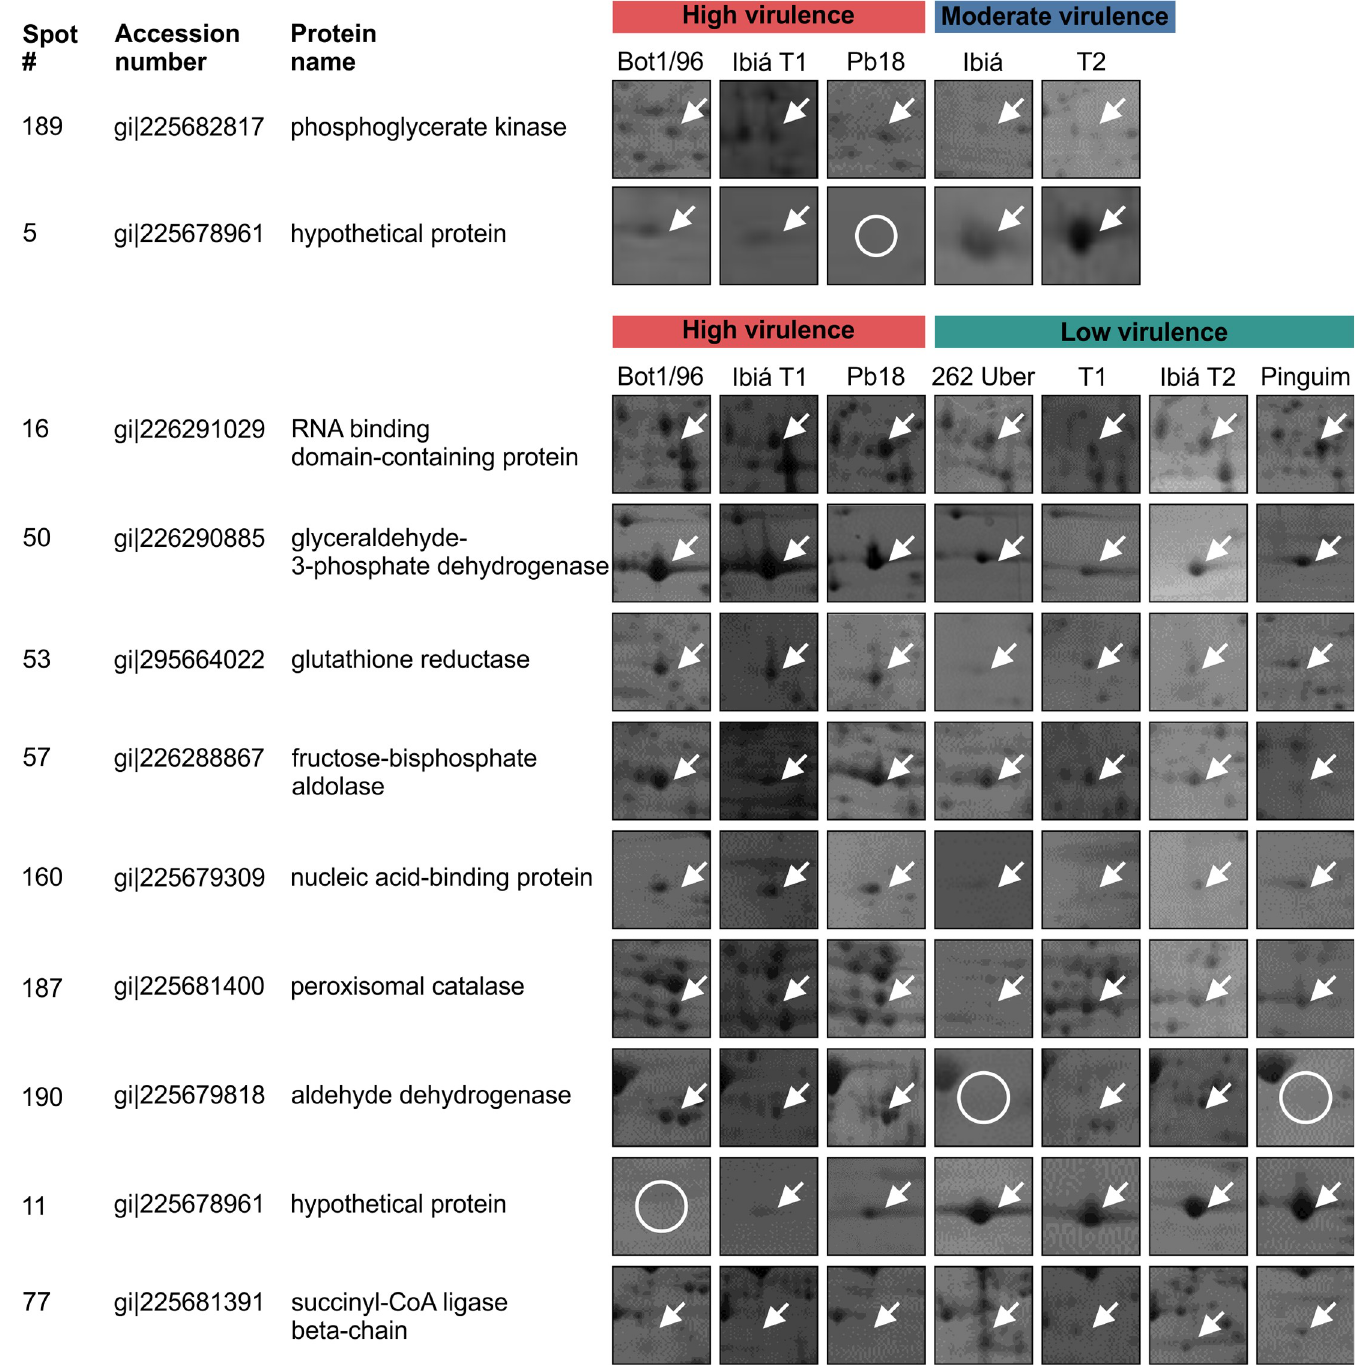
Fig 5. Identification of proteins by LC-MS/MS. Proteins corresponding to the spots of interest in 2D electrophoresis gels were identified by LC-MS/MS. An arrow indicates the presence of the protein, whereas an open circle indicates the absence of the protein. A: Proteins with differential abundance levels between highly and moderately virulent isolates. B: Proteins with differential abundance levels between highly and slightly virulent isolates. The data presented represent the results of three biological replicates.